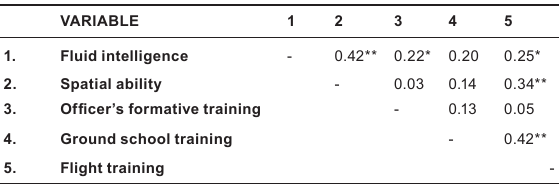
taBle 2 Intercorrelations (Pearson) between predictor variables and criteria of pilot training